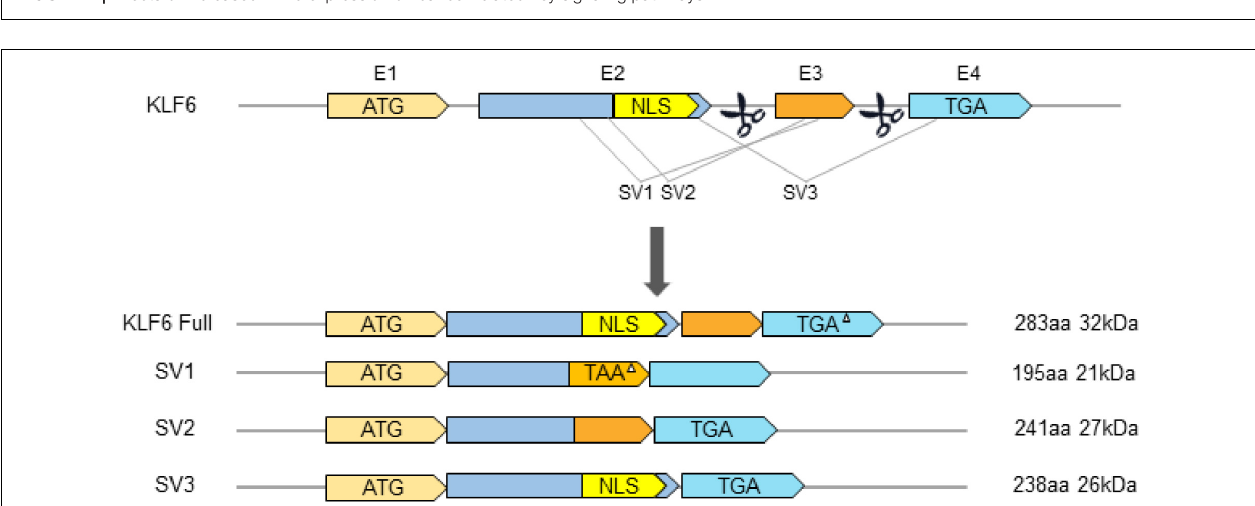
FIGURE 1 | Effects of increased KLF6 expression on cancer-related key signaling pathways.